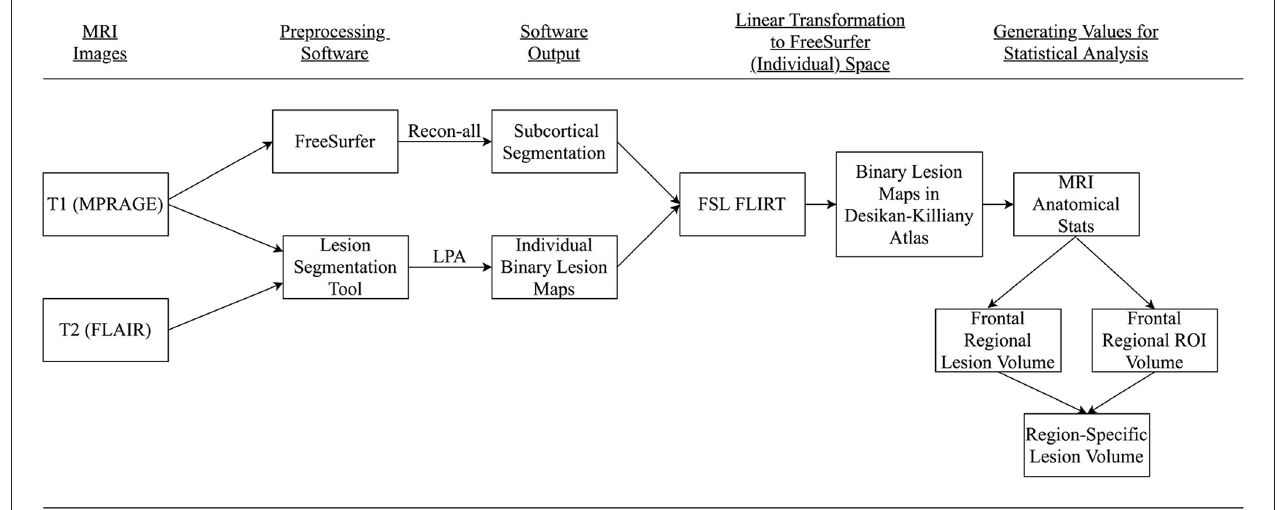
FIGURE 1 | Summary conceptual model of MRI processing. Participant’s MPRAGE and FLAIR were collected and processed using FreeSurfer and Lesion Segmentation Toolbox. Resultant images were transformed to FreeSurfer space, the Desikan-Killiany atlas, via FSL FLIRT. Regional-specific lesion volumes were calculated for final analysis.